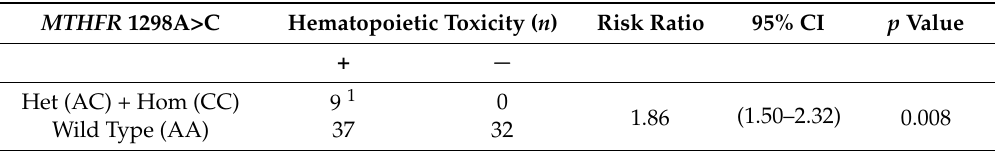
Table 5. Correlation of MTHFR 1298A>C polymorphism with presence of fluoropyrimidine-driven hematopoietic